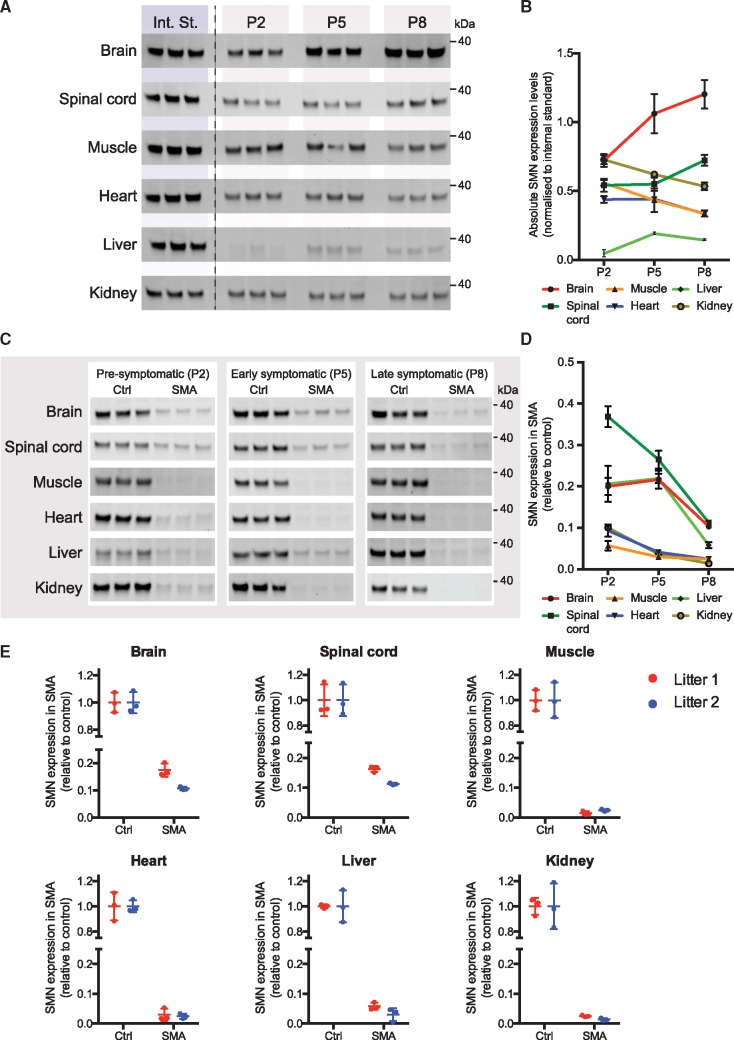
Analysis of SMN expression in control and Taiwanese SMA mice. (A) SMN expression in control littermates (Smn+/−; SMN2tg/0) of the Taiwanese model of SMA was determined using western blot in the indicated tissues. Shown are the internal standard (Int. St.) that was the same for all tissues and loaded in triplicate on each membrane, and SMN expression for each of the tissues at each of the indicated time points (P2, P5 and P8). (B) Quantification of SMN expression in all tissues from (A). Expression was first normalized to a fluorescent TPS and then to the Int. St., to allow direct comparison between membranes (n = 3 biological replicates for each of the tissues at each of the indicated time points, ± SEM). All tissues for each time point were obtained from the same litter. (C) SMN expression is shown for each of the indicated tissues at pre-, early and late-symptomatic ages (P2, P5 and P8) for both control (n = 3 for each tissue and each time point, Smn+/−; SMN2tg/0) and SMA (n = 3 for each tissue and each time point, Smn−/−; SMN2tg/0) mice. (D) Quantification of relative SMN depletion in each of the tissues at each of the time points. SMN expression in each sample was first normalized to a fluorescent TPS. SMN expression in SMA littermates is shown relative to control. (E) SMN levels were determined in each of the six tissues in two independent litters at the late-symptomatic time point (P8). kDa: 40 kDa molecular weight marker, see Supplementary Material for uncropped western blot membranes.